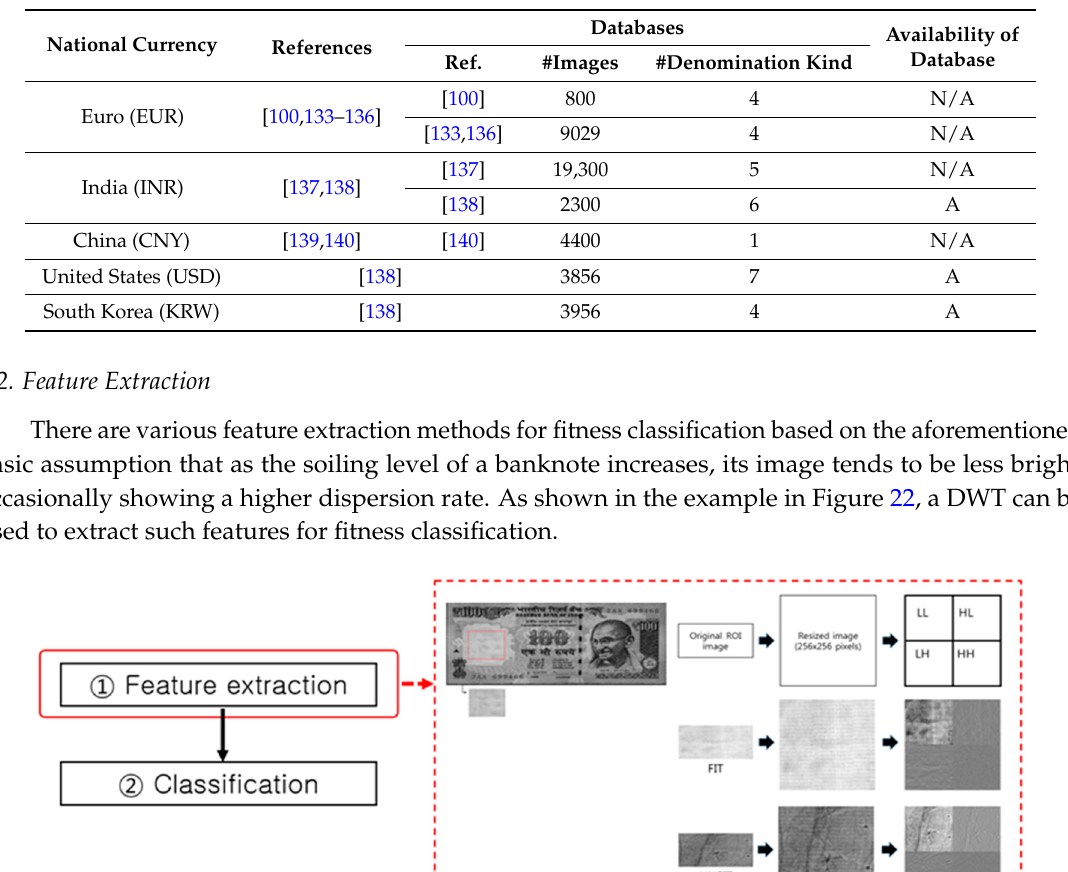
Table 14. Studies on fitness classification by national currency (Ref.: References, A: Available, N/A: Not Available).